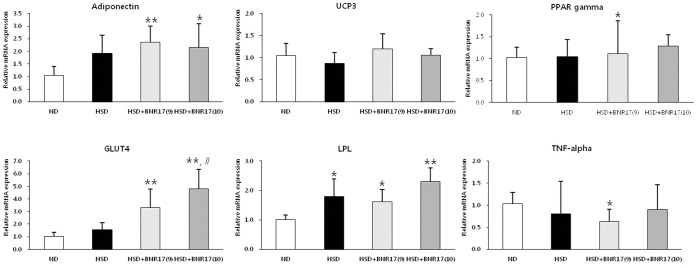

L. gasseri BNR17 affects mRNA expression in white adipose tissue.C57BL/6J mice were given ND, HSD, or HSD containing BNR17 (109 or 1010 CFU) for 10 weeks. The white adipose tissue was then removed and mRNA expression was measured by real-time RT-PCR using β-actin as a housekeeping gene. Data represent the means ± SD. Pairwise t-test: *P<0.05, **P<0.01 versus the ND group; #
P<0.05 versus the HSD group.